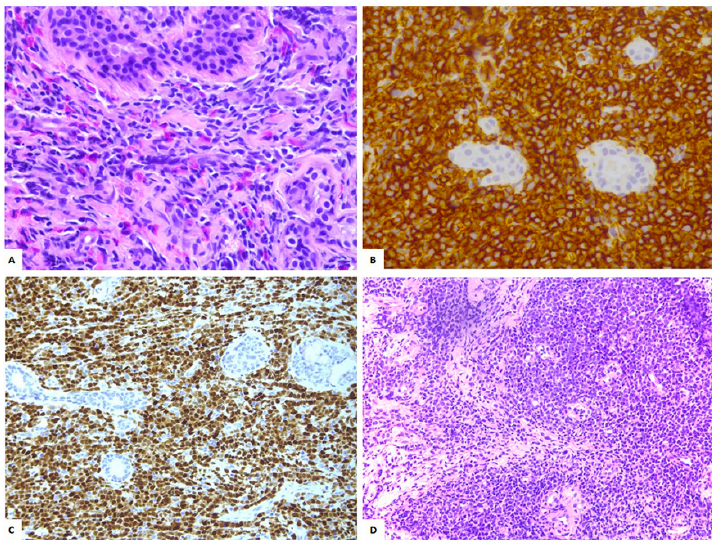
Figure 1. ( A ) Isolated myeloid sarcoma (MS) involving the right breast (40 × , H&E): Di ff use infiltration by blasts with occasional eosinophils. ( B ) The neoplastic cells show immunoreactivity for CD34 (40 × ). ( C ) Anti-TdT immunohistochemical staining (20 × ). ( D ) Fine-needle biopsy confirmed the presence of a monotonous population of blasts diagnosis of MS involving the left breast (20 × ,